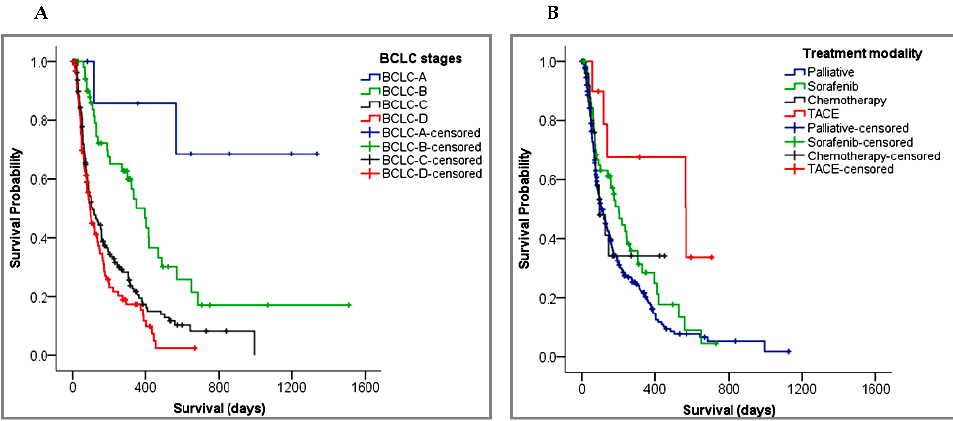
Figure 4. Kaplan – Meier survival curves for HCC patients with different: ( A ) BCLC stages; ( B ) treat- ment modalities. Censored patients are marked as “+” and represent patients who were lost during follow-up or alive at the end of the study. BCLC, Barcelona Clinic Liver Cancer staging system. TACE, transarterial chemoembolization. Table 4. Univariate and multivariate analysis of factors associated with survival of HCC patients.